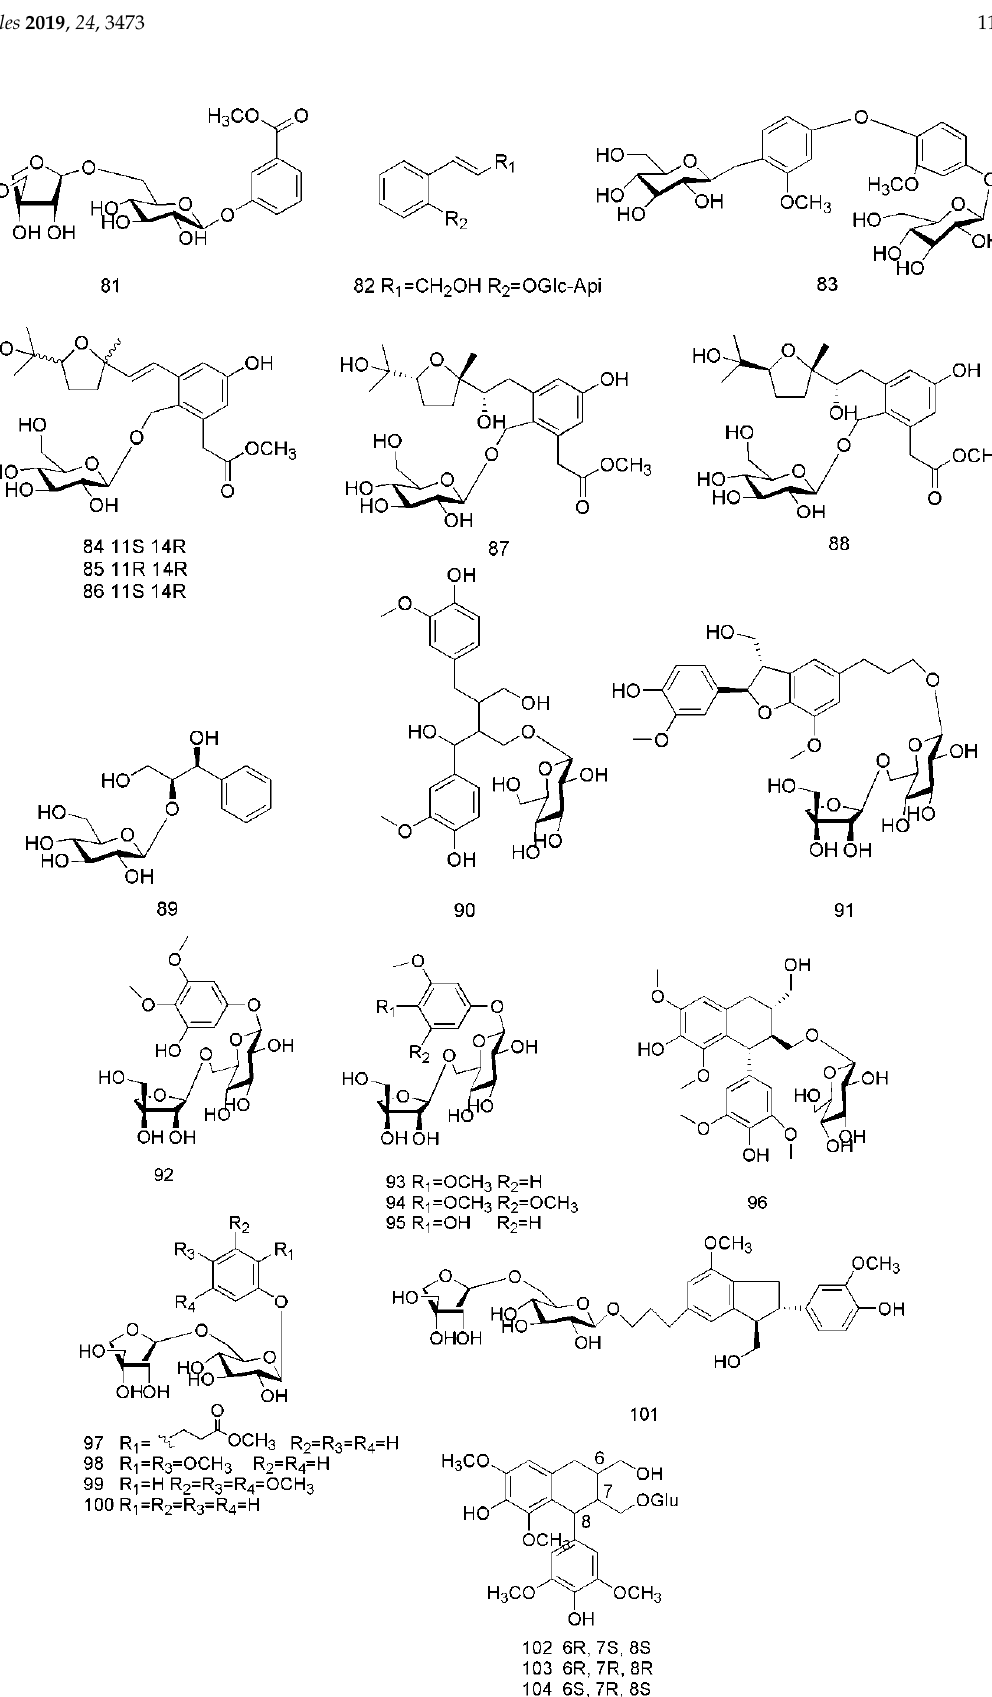
Figure 6. Chemical structures of the glycosides in C. cassia .